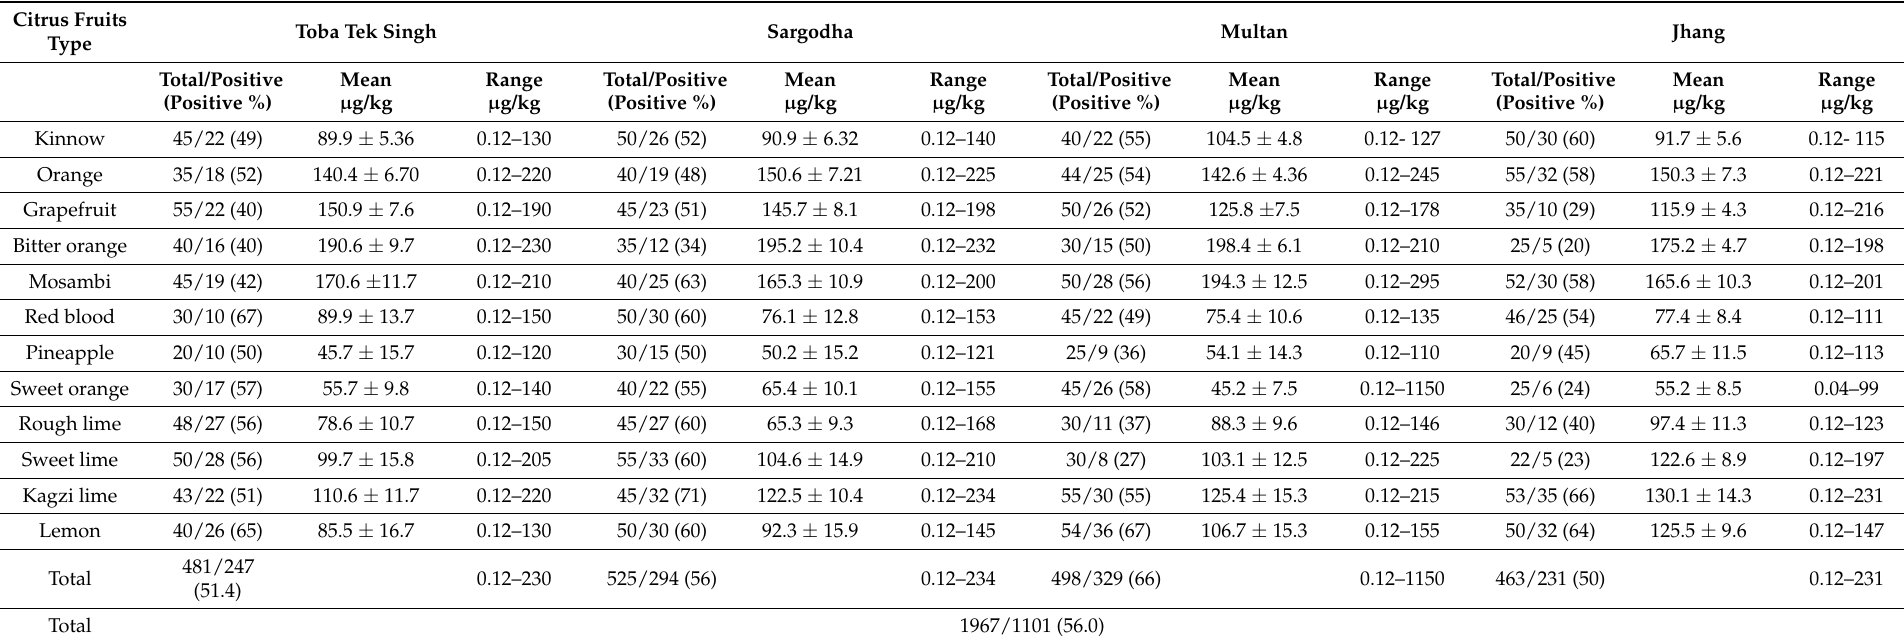
Table 2. Incidence levels of patulin in selected citrus fruit samples from central cities of Punjab,